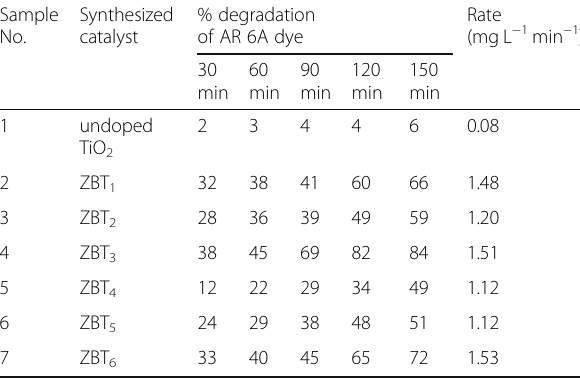
Table 4 Effect of dopants concentration on degradation of AR 6A under stimulated visible light irradiation, AR 6A = 10 mg L − 1 , pH = 6 and catalyst dosage 50 mg L − 1 Sample